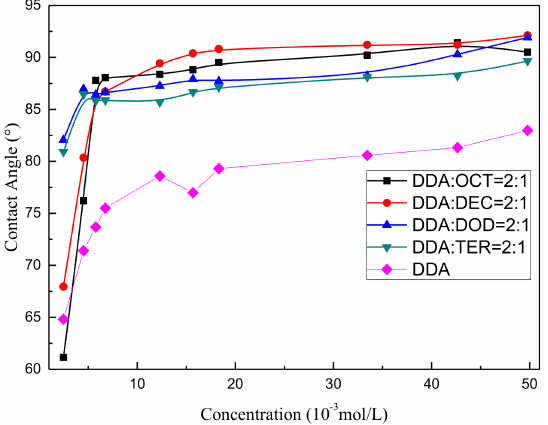
Figure 4. Contact angle of muscovite as a function of mixed collector dosage.